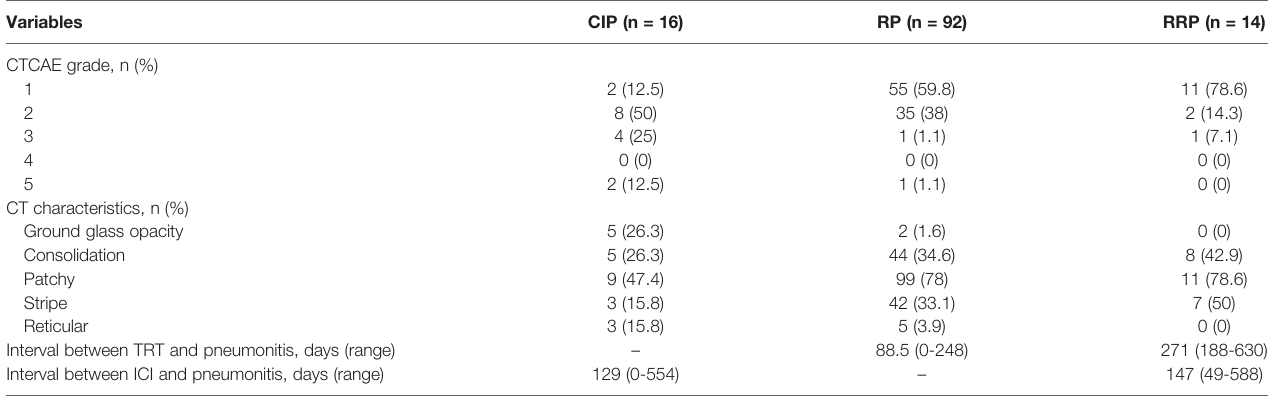
TABLE 2 | Characteristics of different types of